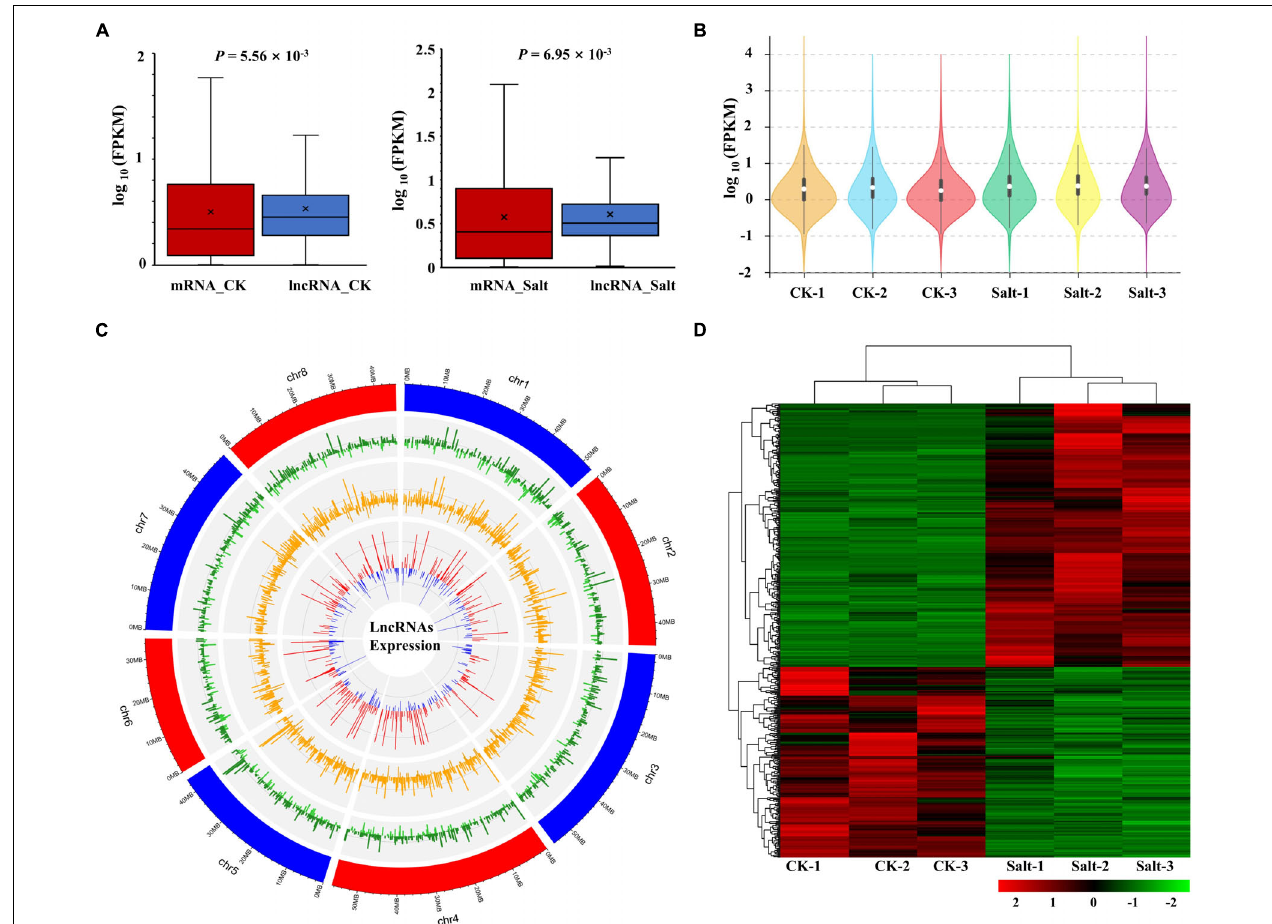
FIGURE 4 | Expression analysis of lncRNAs. (A) Comparison of the expression levels between lncRNAs and mRNAs in the CK and Salt groups. (B) FPKM distribution of lncRNAs in six samples. (C) Genomic distribution of lncRNAs. The three circles (from outer to inner) represented the expression levels (log 10 FPKM) of lncRNA in the CK group, lncRNA in the Salt group, and fold change of the expression levels, respectively. (D) The heat map of all DElncRNAs.